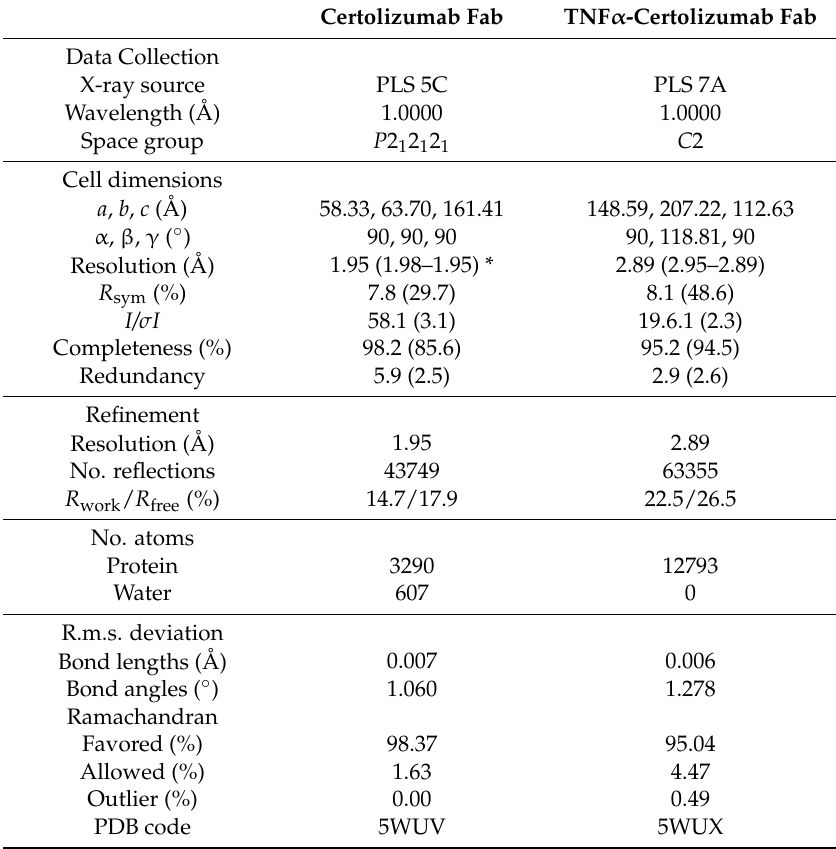
Table 3. Data collection and refinement